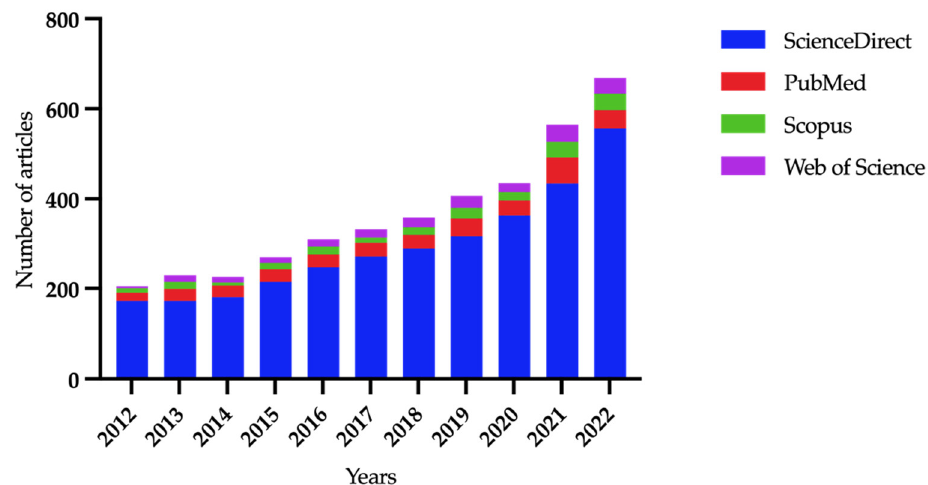
Figure 2. PC-related articles during the last decade in four databases: ScienceDirect, PubMed, Scopus, and Web of Science.